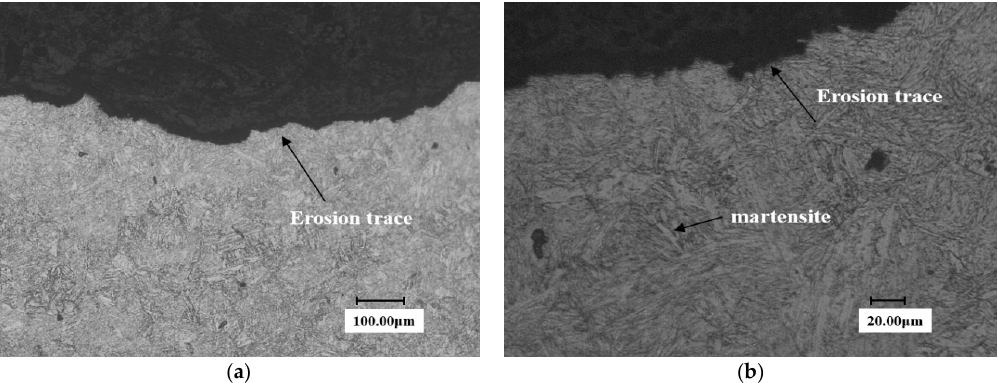
Figure 11. Metallographic diagram of substrate surface. ( a ) Close to end face of the erosion trace (×300) ( b ) Close to end face of the erosion trace (×1.0 k).